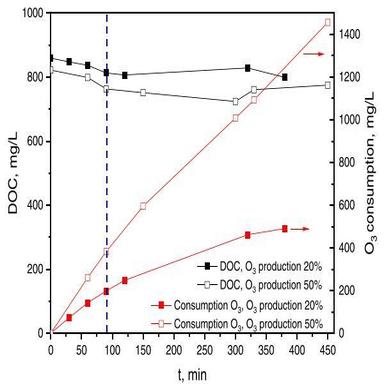
DOC evolution and O3 consumption versus treatment time during the ozonation process under different operating conditions.